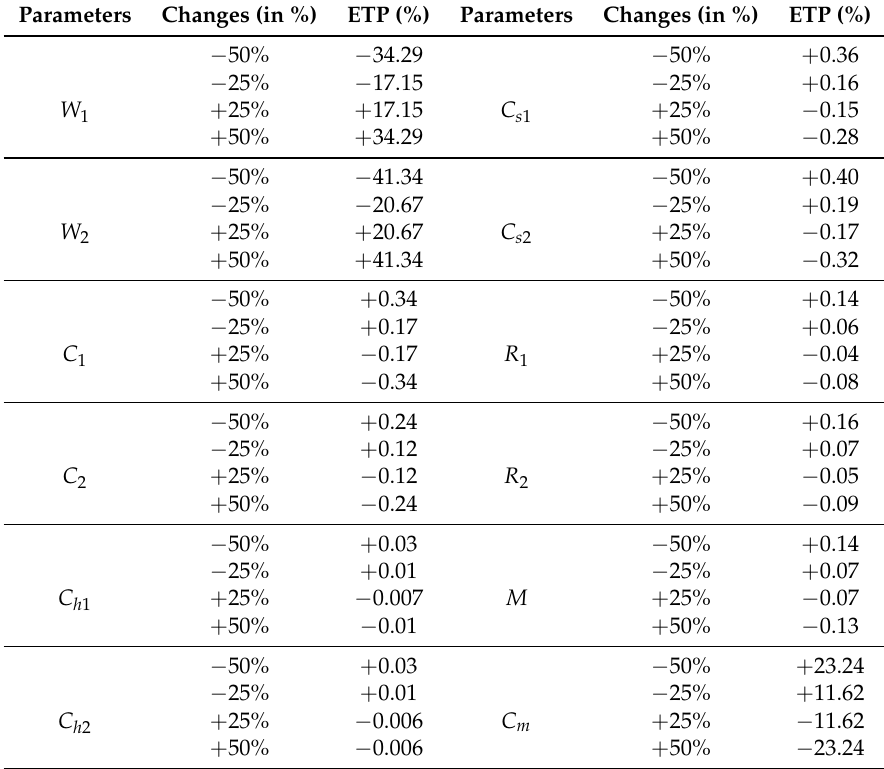
Table 6. Sensitivity analysis of key